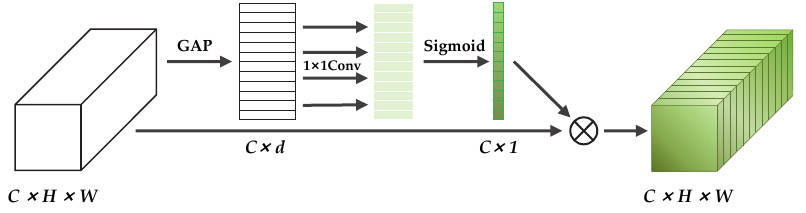
Figure 7. The structure of feature attention module.